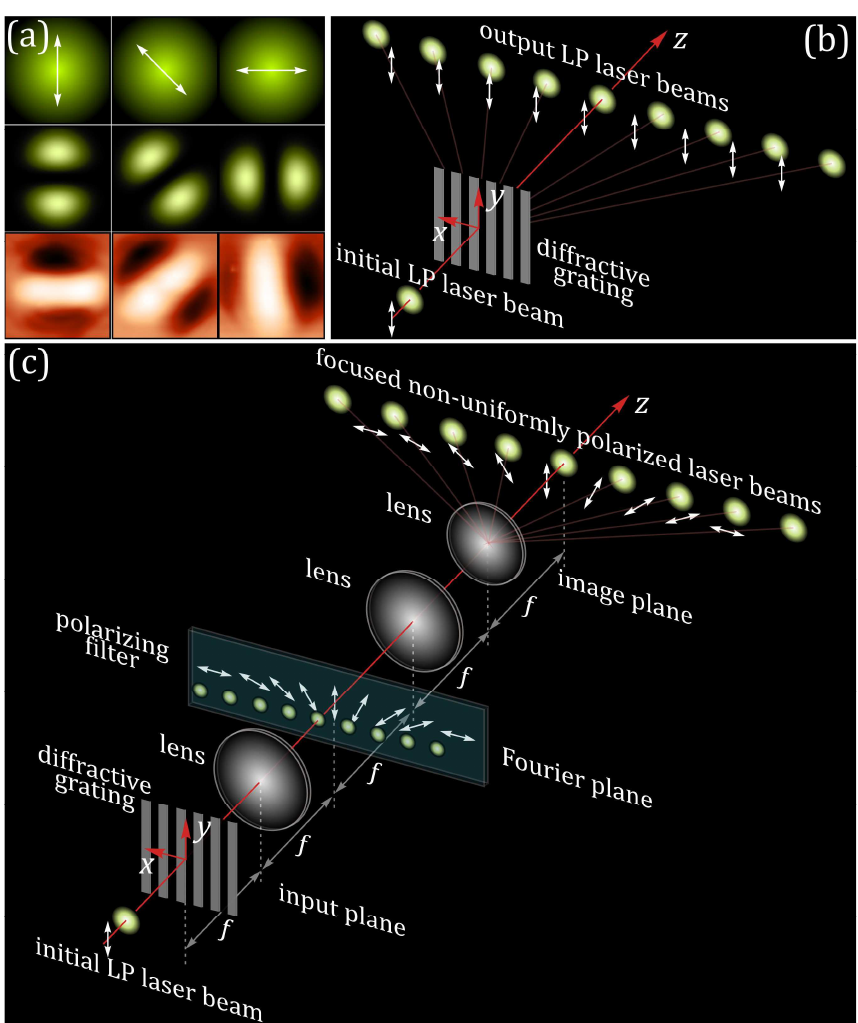
Figure 1. Concept of approach for implementation of polarization-sensitive patterning of azopolymer thin films using multiple structured laser beams. ( a ) Intensity distributions (top row) and the longitudinal components (middle row) of focused linearly polarized (LP) Gaussian laser beams with different polarization directions, as well as images of the microstructures formed in thin azopolymers films under the illumination of these beams (bottom row). ( b ) Splitting of a single LP Gaussian laser beam into a set of LP laser beams with a one-dimensional diffractive grating. ( c ) Principle of spatial polarization filtering and generation of a set of LP laser beams with different polarization directions using a 4- f optical system with a polarizing filter. Each light spot shaped at the Fourier plane of the 4- f optical system is incident on different areas of the polarizing filter. If a half-wave plate is used as a polarizing filter, each section of the filter performs the same transformation of the initial linear polarization of each light spot—for all spots, the polarization axis rotates by the same angle, equal to the double angle of rotation of the half-wave plate axis. When a q -plate is used as a polarizing filter in each region of the plate where the shaped light spots are incident, the angle of the rotation of the original linear polarization is determined by the structure of